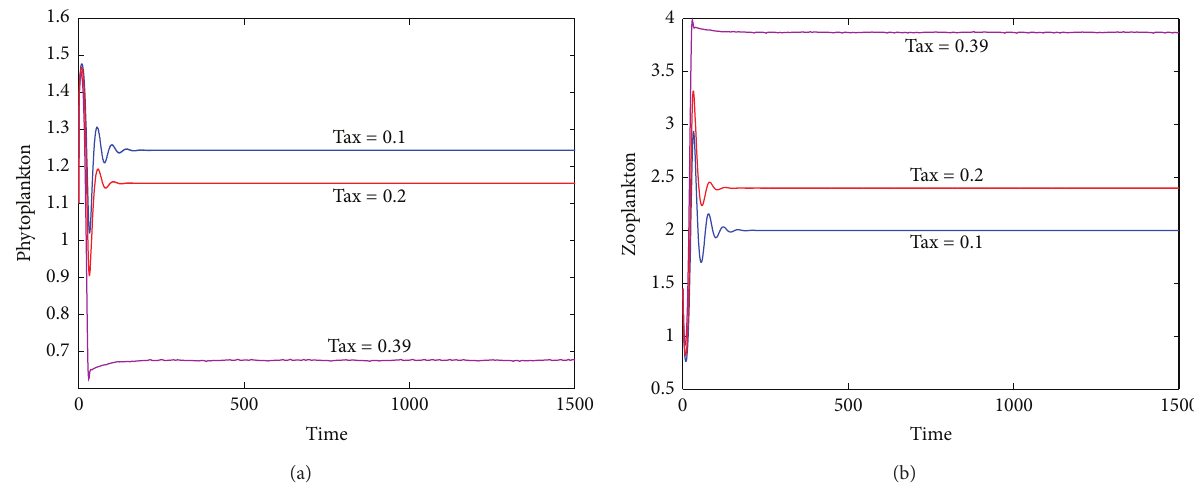
Figure 7: (a) Variation of phytoplankton population with time for different tax levels. (b) Variation of zooplankton population with time for different tax levels.